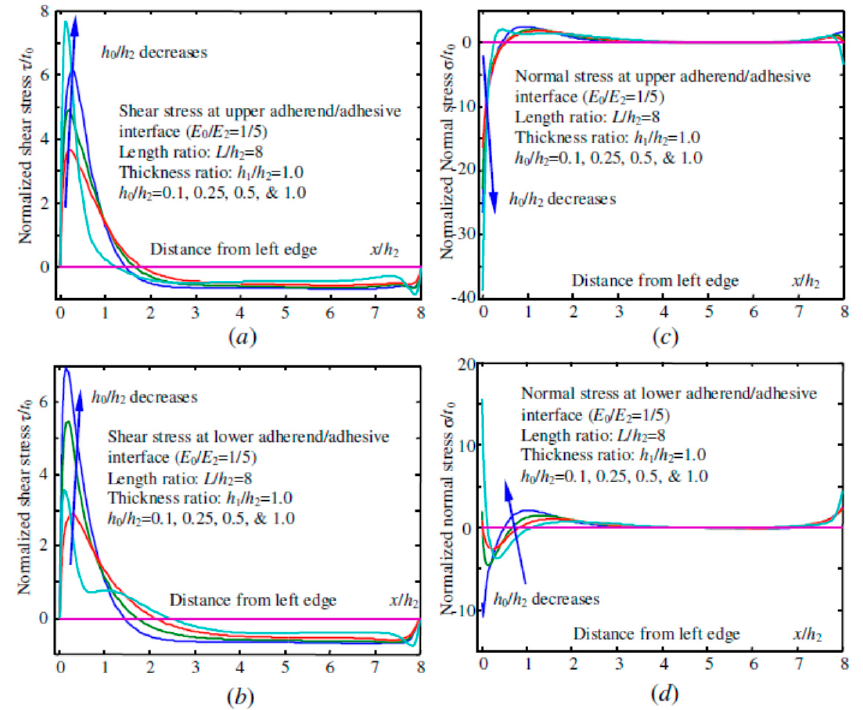
Figure 6. Comparison of the interfacial shear and normal stresses at the upper and lower ad- herend/adhesive interfaces subjected to a shear force ( E 0 / E 2 = 1/5, h 1 / h 2 = 1.0, and h 0 / h 2 = 0.1, 0.25, 0.5, and 1.0, respectively). ( a , b ): Shear stresses at the upper and lower adherend/adhesive layer interfaces, respectively; ( c , d ): Normal (peeling) stresses at the upper and lower adherend/adhesive layer interfaces,